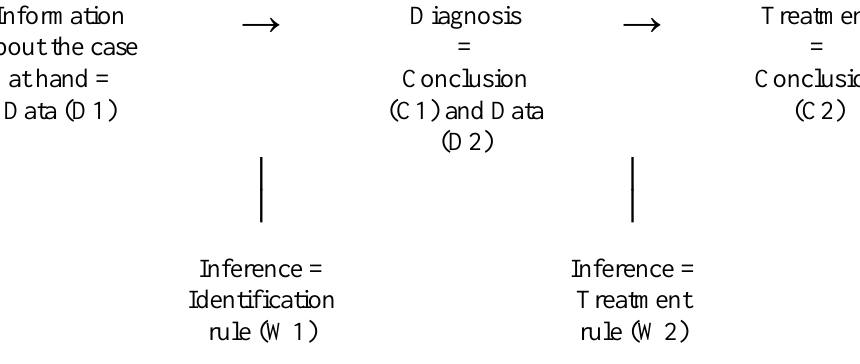
Figure 2 The components of discretionary reasoning in professional work